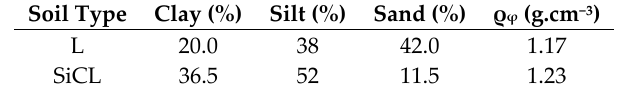
Table 1. Soil particle size distribution and bulk density, ρ φ , of the soils